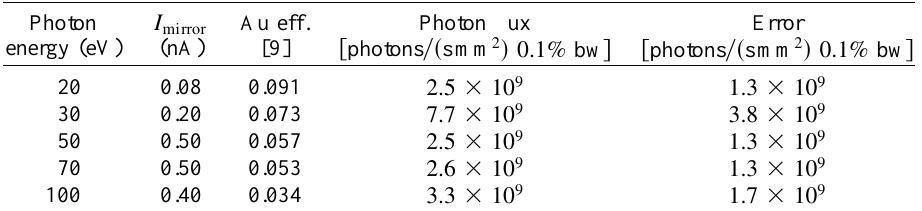
TABLE I. The measured monochromatic flux on the last refocusing gold mirror of the TGM7 beam line. Photon I mirror Au